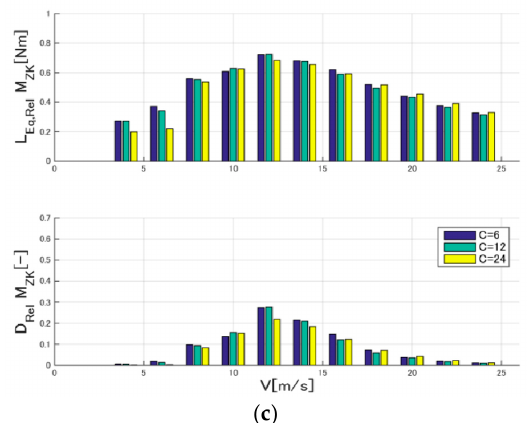
Figure 16. Relative DEL and fatigue damage from the tower loads with C = 12 (8.5 m/s of the annual average wind speed, m = 4): ( a ) tower base fore ‐ aft bending moment; ( b ) tower top nodding moment; and ( c ) tower top yawing moment.